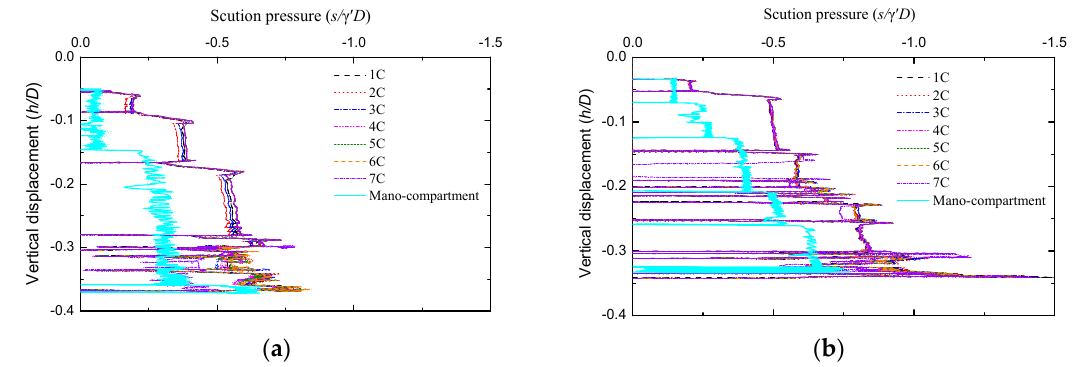
Figure 11. Relationship curve between the penetration depth and applied suction for mono-compartment and multi-compartment bucket foundations. ( a ) PS1-1 and PS2-1; ( b ) PS1-2 and PS2-2.